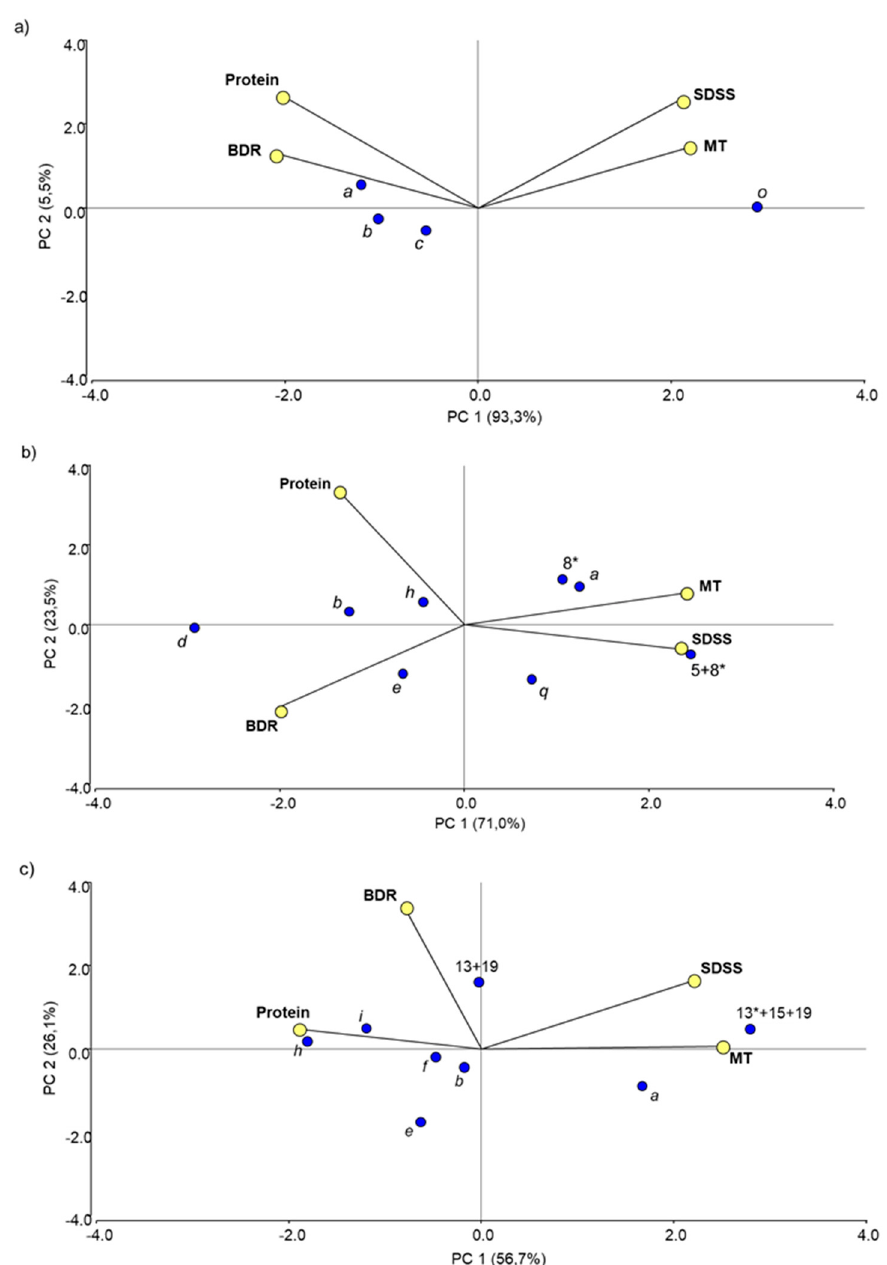
Figure 4. First and second principal components for the alleles present in at least three landraces and the quality traits. ( a ) Glu-A1 . ( b ) Glu-A3 . ( c ) Glu-B3